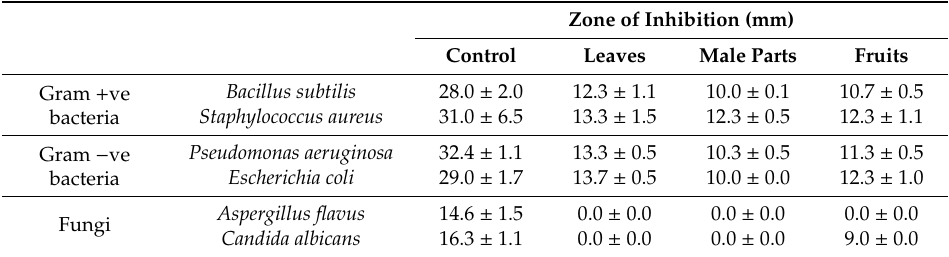
Table 4. Antimicrobial activity of H. thebaica leaves, male parts and